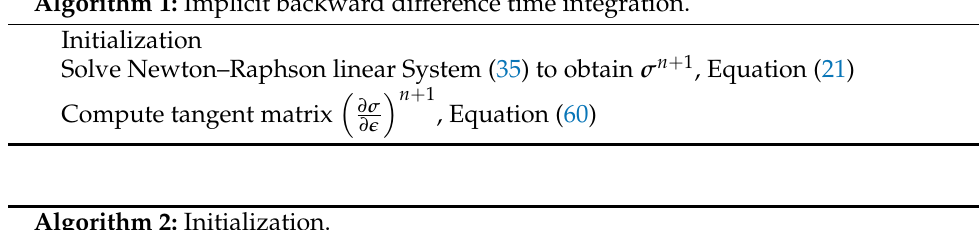
Algorithm 2: Initialization.